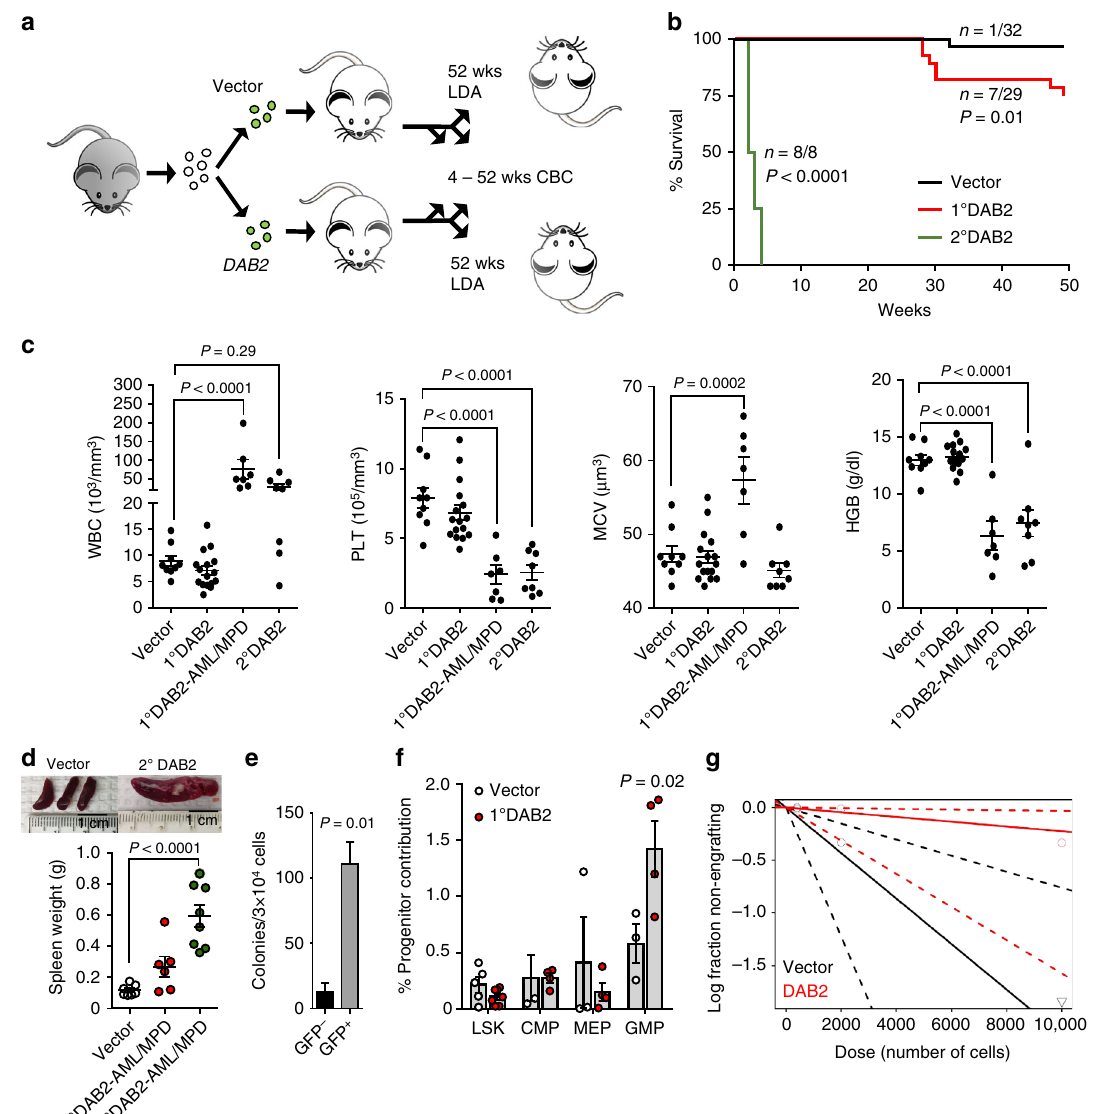
Fig. 5 Enforced expression of DAB2 predisposes mice to a serially transplantable myeloid malignancy. a Schematic of the primary transplant experiment analyzed in b through g . CBC complete blood counts, LDA limiting dilution assay. b A Kaplan – Meier survival curve was generated for mice receiving transplanted marrow containing Vector or DAB2 constructs following primary (1° DAB2) or secondary transplant (2° DAB2) in those mice dying of myeloproliferation or leukemia. c Peripheral blood analysis of white blood cells (WBCs), platelets (Plt), mean cell volume (MCV), and hemoglobin (HGB) at 25 weeks post transplant (mean ± SEM, Vector n = 9, 1° DAB2 n = 16, 1° DAB2-AML/MPD n = 7, 2° DAB2 n = 8). d Spleen weights were assessed in primary and secondary recipients (mean ± SEM, Vector n = 6, 1° DAB2-AML/MPD n = 6, 2° DAB2-AML/MPD n = 8). e CFU analysis was performed using primary DAB2 -AML/MPD marrow sorted for GFP (mean ± SEM, GFP- BM n = 3, GFP + BM n = 4). f Frequency of LSK (Lin − Sca1 + c-Kit + ), CMP (Lin − Sca1 − c-Kit + CD34 + CD16/32 lo ), GMP (Lin − Sca1 − c-Kit + CD34 + CD16/32 hi ) and MEP (Lin − Sca1 − c-Kit + CD34 − CD16/32 lo ) determined by fl ow cytometry in GFP + marrow of 1° DAB2 mice 60 weeks post transplant that did not develop leukemia or a myeloproliferative disorder (mean ± SEM, Vector n = 3 – 5, 1° DAB2 n = 3 – 4). g Secondary limiting dilution assays using marrow from long-term engrafted Vector or DAB2 mice (52 weeks post-primary transplant). Engraftment was evaluated in secondary recipients at 16 weeks post transplant. Shown is a log-fraction plot of the limiting dilution model. The slope of the line is the log-active cell fraction. The dotted lines give the 95%